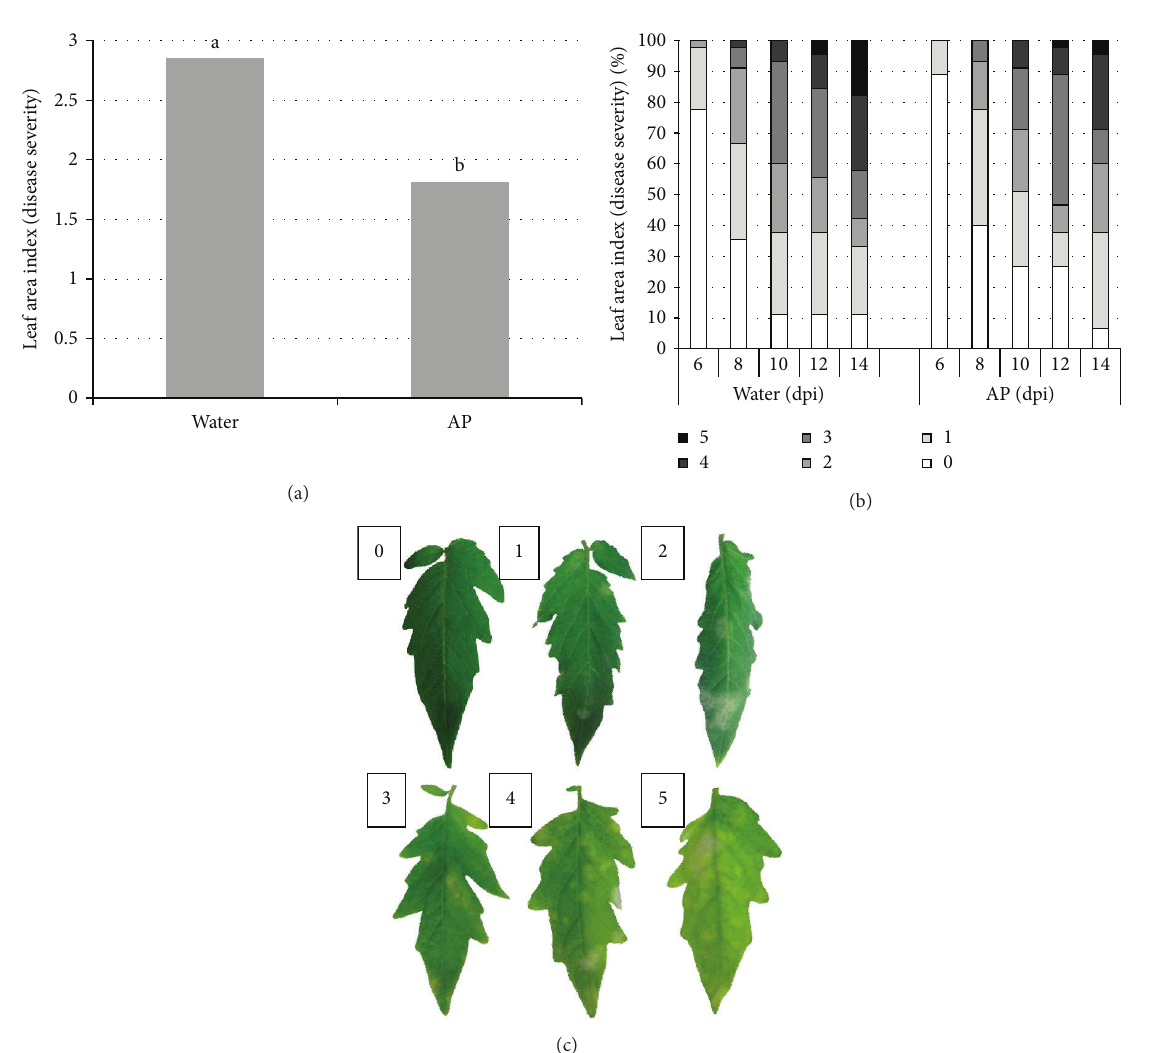
Figure 1: Plant pathogen ( S. lycopersicum cv. House Momotaro— Oidium spp. ) interaction in the presence of algal product (AP) elicitor. Tomato (HM) plants were spray-washed with AP (1%) or H 2 O and introduced into a growth chamber containing Oidium spp. infected plants 1 day later, and disease development was assessed daily from the 6th until the 14th day after the introduction. (a) Disease severity on S. lycopersicum leaves 10 days after disease introduction. Different letters indicate significant differences at ( 𝑃 < 0.05 ). (b) Percentage of infected leaves and disease severity of the AP- and H 2 O-treated plants from 6th until 14th day after pathogen introduction. Disease severity was quantified in reference to (c). (c) Development of Oidium spp. on S. lycopersicum leaves was marked from 0 (if the leaf was not infected) to 5 (if the leaf was fully infected) and this reference was made for this purpose accordingly. Three plants were used in each experiment. Results are the average of three independent